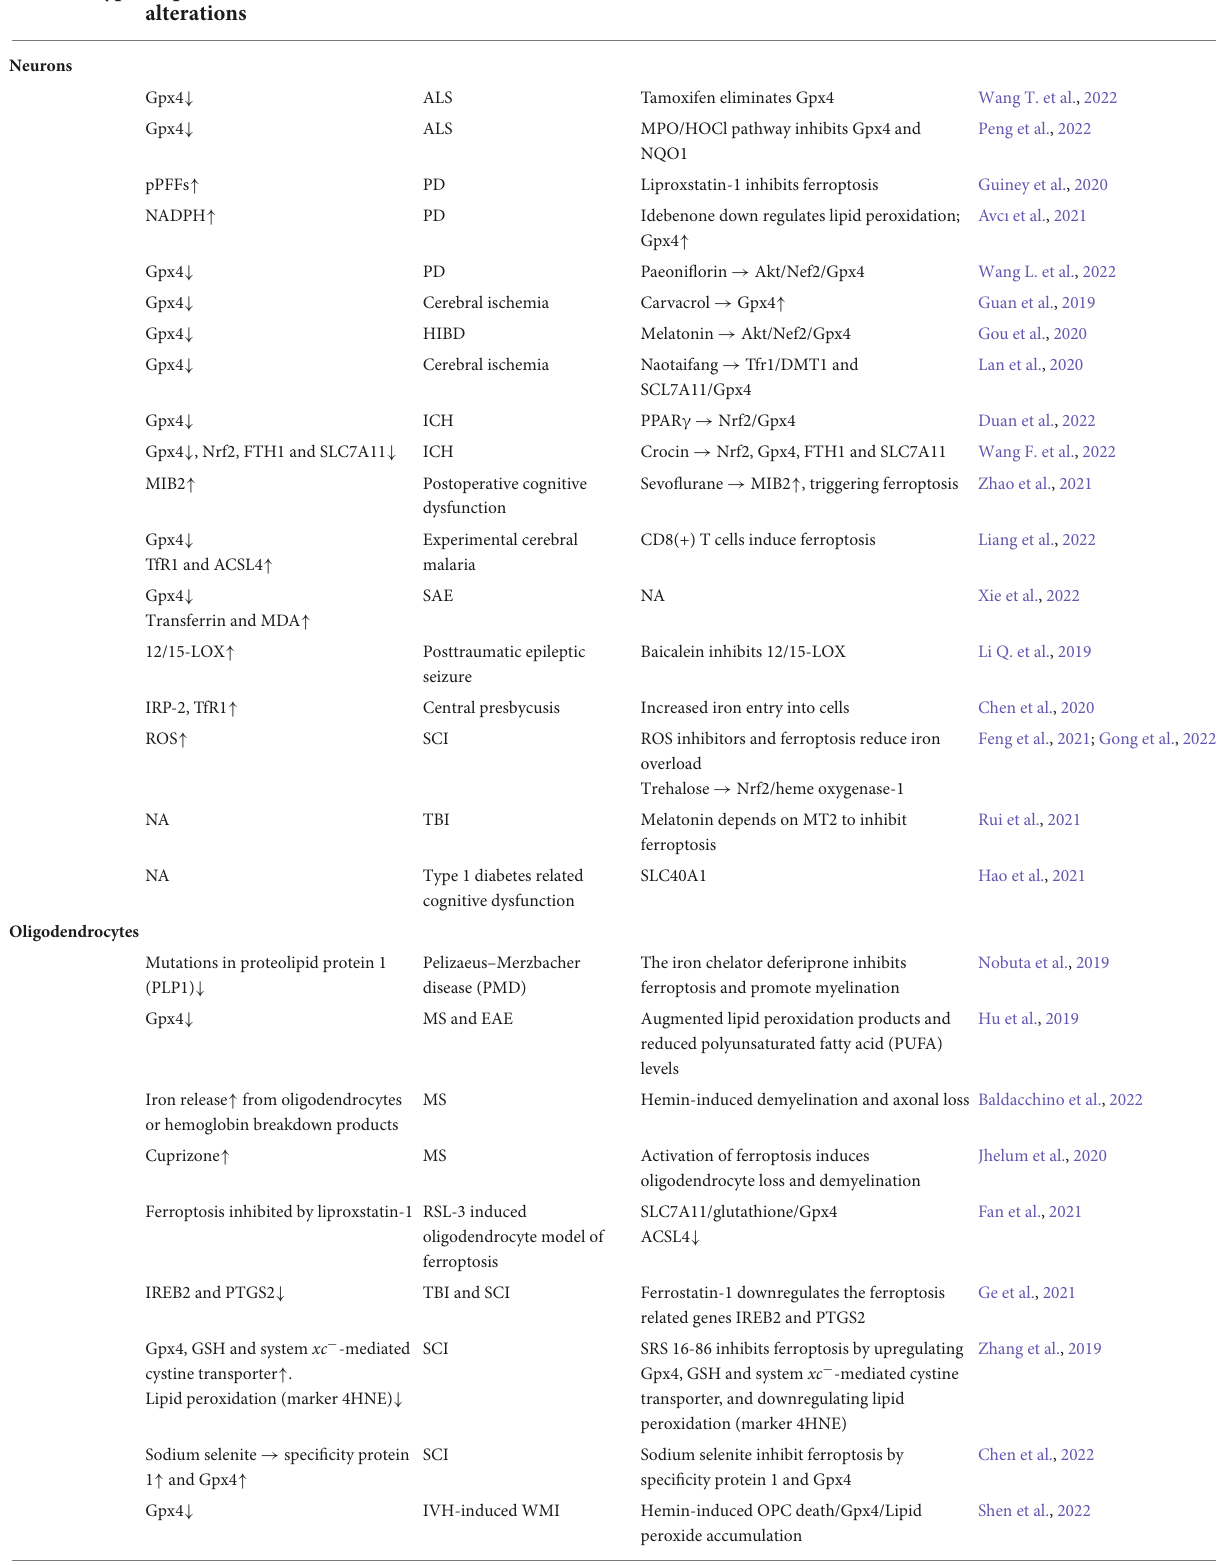
TABLE 1 The roles of ferroptosis in different central nervous system (CNS) cell types and brain